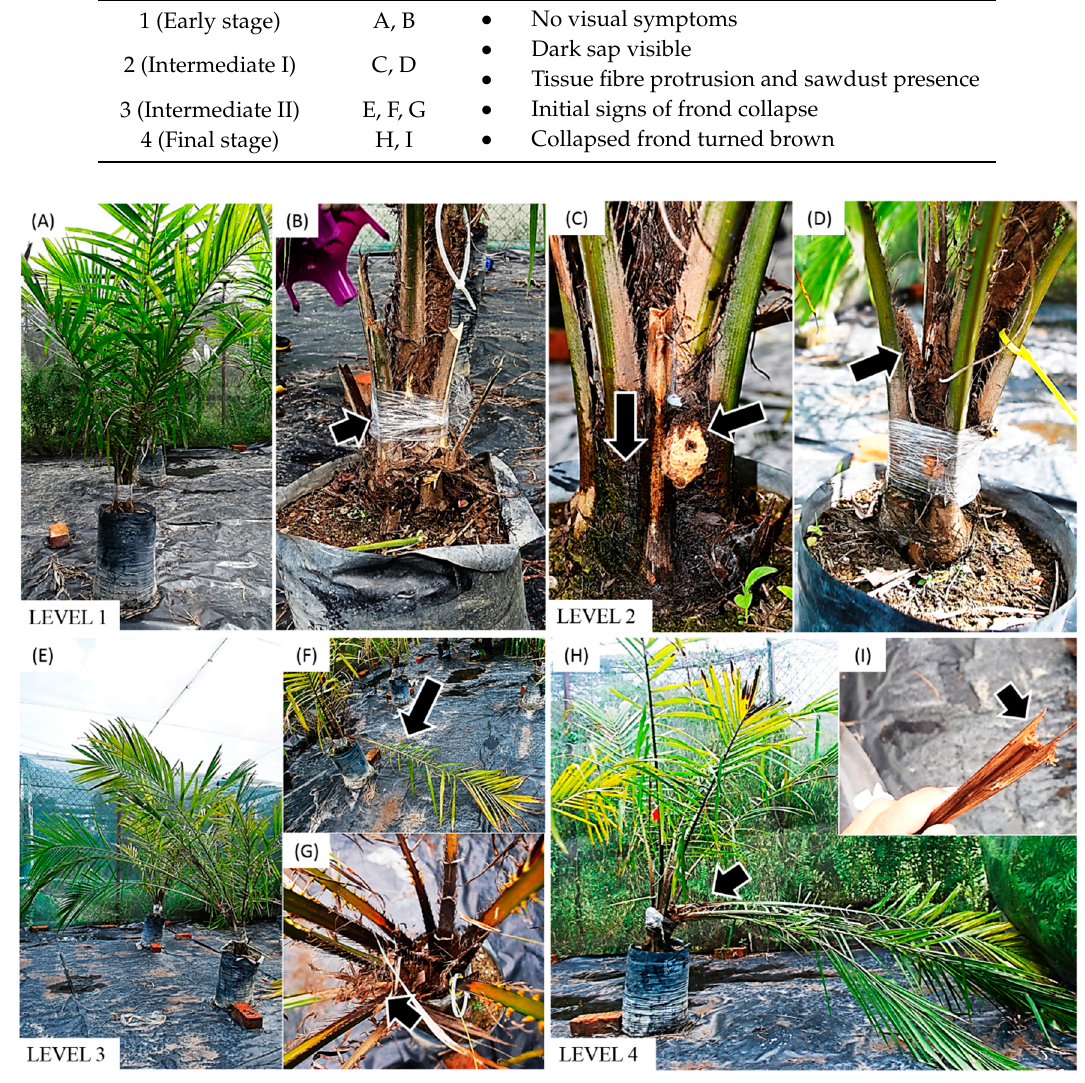
Figure 1. Visual symptom level of RPW infestation in oil palm plantlings based on empirical observations in this greenhouse experiment. ( A , B ) Level 1 infestation observed between first to the third week: no symptoms visible especially at the sealed crown base. ( C , D ) Level 2 infestation observed between fourth to sixth week: dark oozes and smelly sap together with soft, creamy-coloured tissue appeared at the crown base; brown sawdust recorded between the plantling’s trunk and the base of the leaves. ( E – G ) Level 3 infestation observed between sixth to ninth week: host plant’s shoot started to lean to the ground; the leaves started to fall; loss of symmetry at palm upper crown. ( H , I ) Level 4 infestation observed at the ninth week: leaves collapsed and started to show skirting shape; shoot was dried out and fell off.